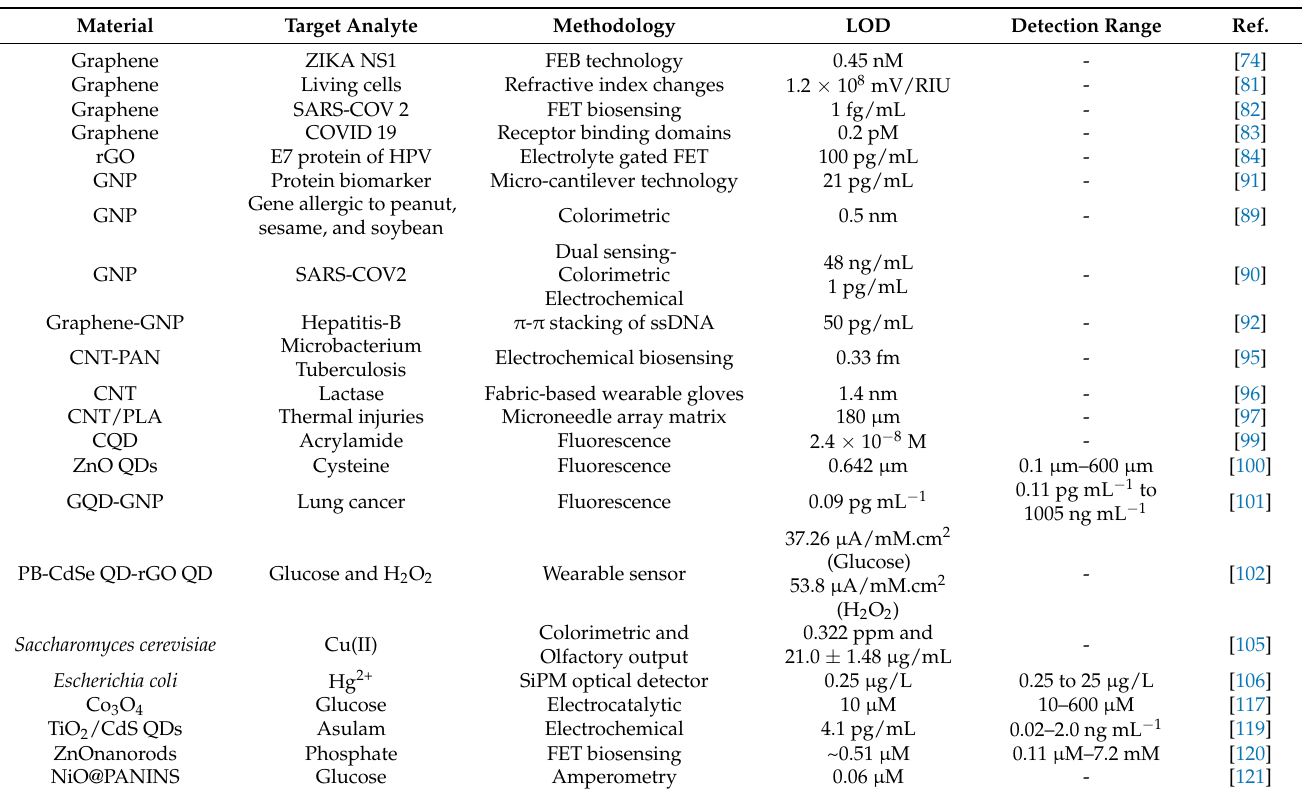
Table 1. Nanomaterials used in biosensors for the detection of various